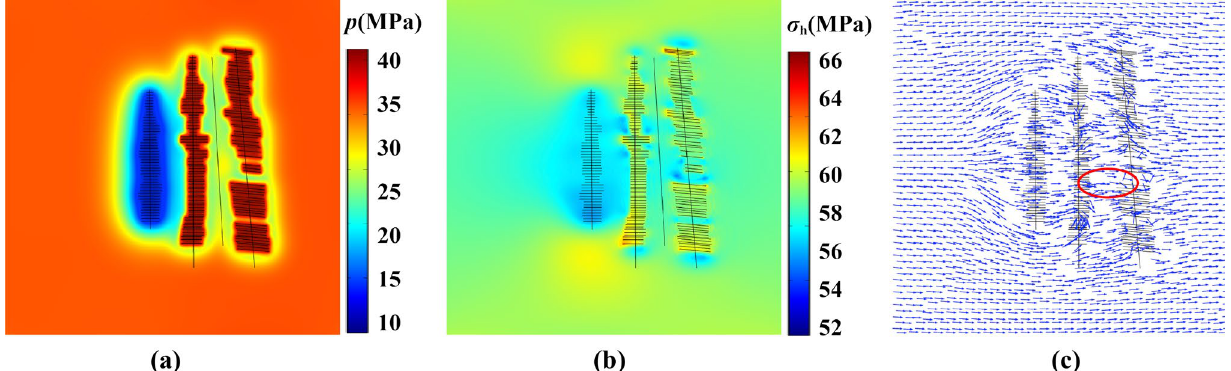
Fig.10 Pressure and stress field after injection of the two parent wells M-P2 and M-P3 when ξ zontal stress; c orientation of maximum horizontal stress σ H